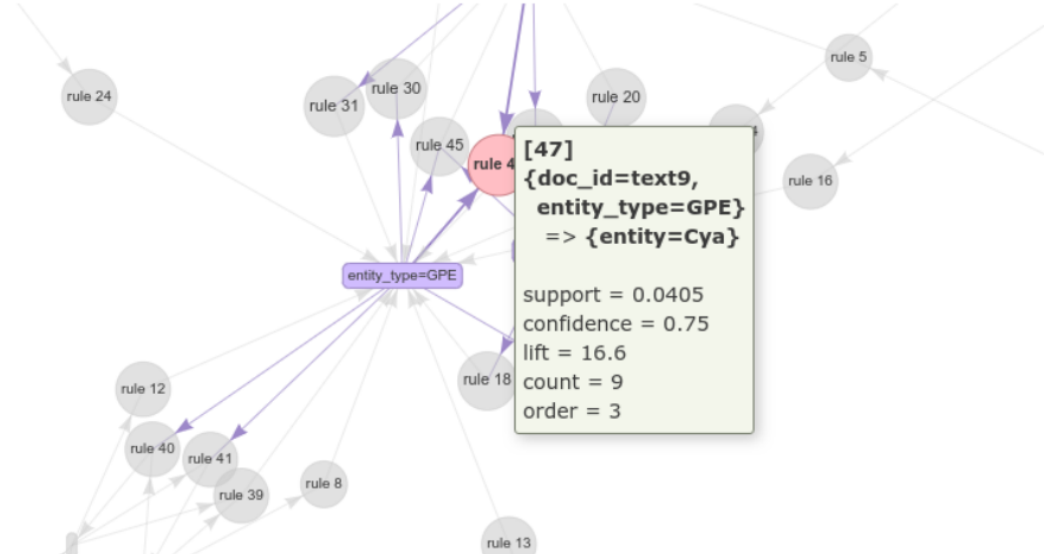
Figure 8. Some semantic association rules after using the proposed